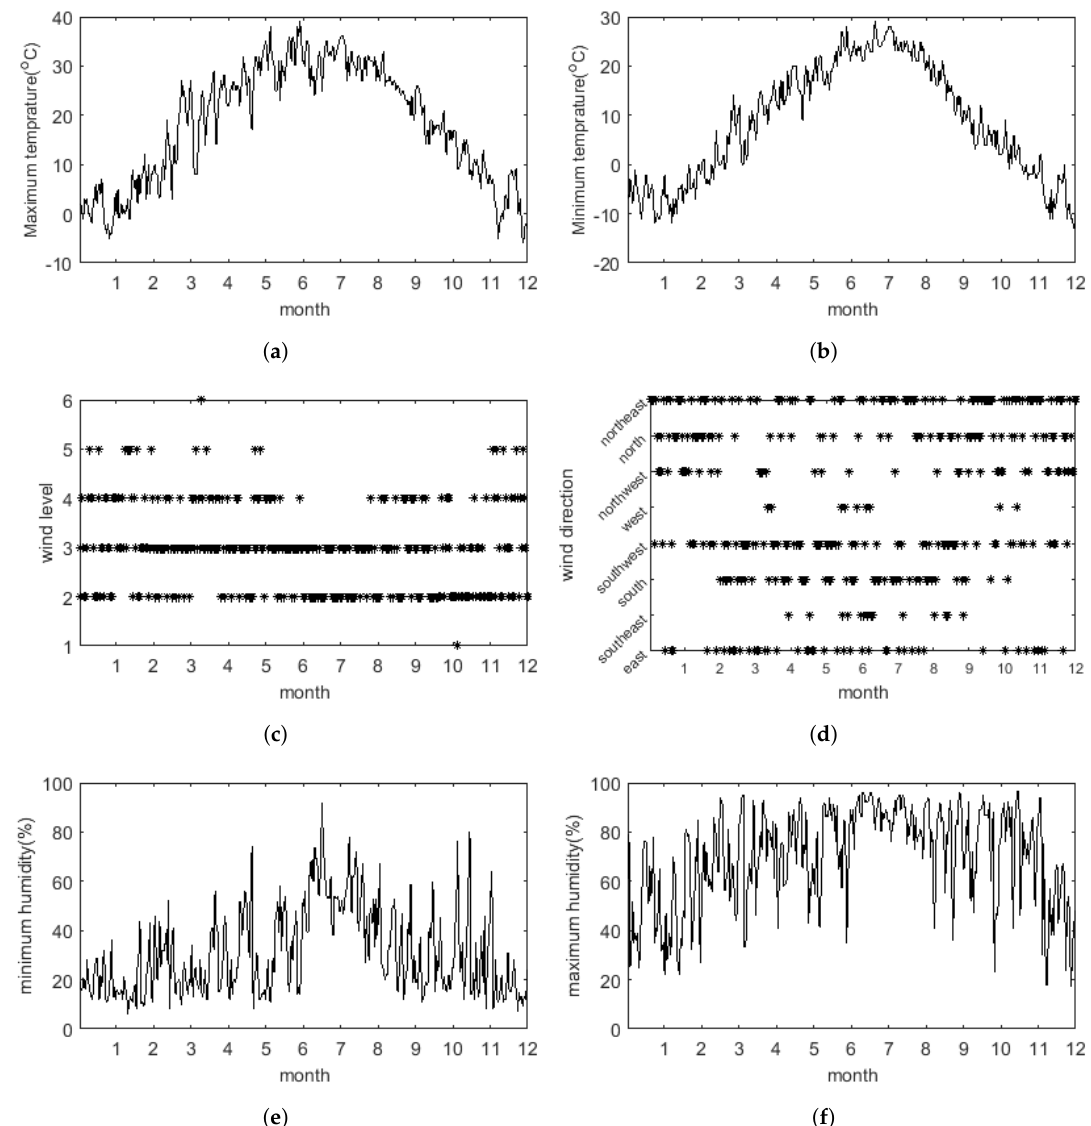
Figure 6. The meteorological condition of Beijing in 2018. ( a ) The daily maximum temperature (degree centigrade), ( b ) the daily minimum temperature (degree centigrade), ( c ) the maximum wind level (force 1 to force 6), ( d ) the wind direction in the presence of the maximum wind level. ( e ) The daily minimum humidity (%); ( f ) the daily maximum humidity